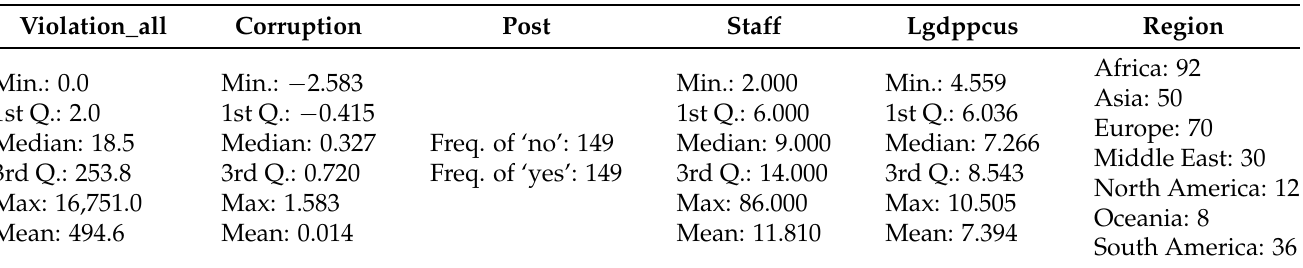
Table 5. Univariate descriptive statistics of the quantitative variables and frequency table of the qualitative variables that were considered in the models.